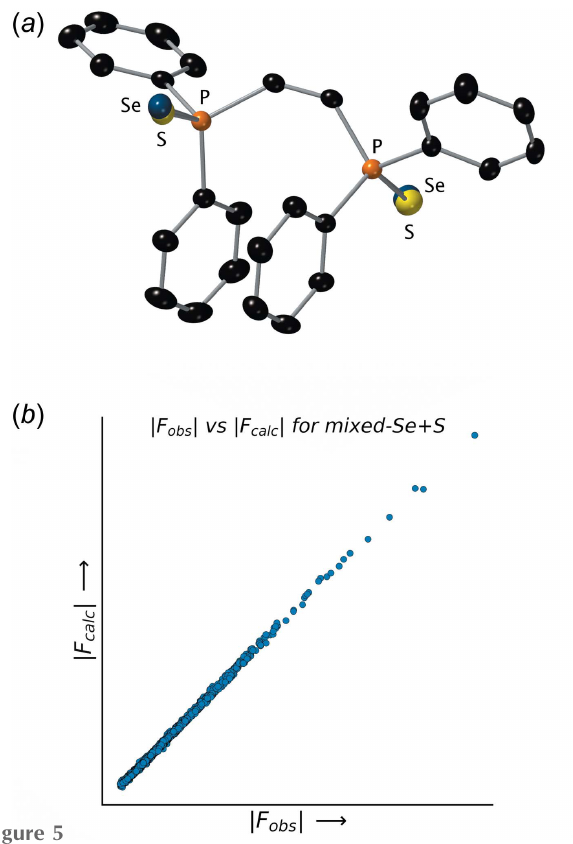
Figure 5 ( a ) An ellipsoid (50% probability) plot for the mixed selenide/sulfide model. Note that all ellipsoids appear quite normal. ( b ) A plot of | F obs | vs | F calc | values for the mixed selenide/sulfide model. Note the much reduced scatter in the plot relative to Figs. 2 and 3.